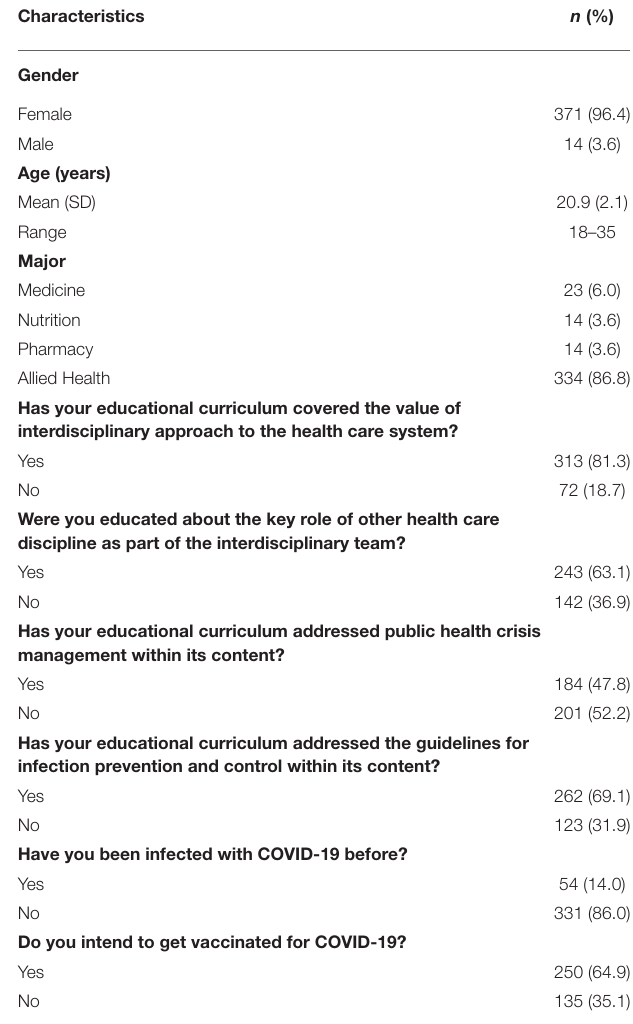
TABLE 1 | Socio-economic and demographic characteristics of the study participants ( N = 385).